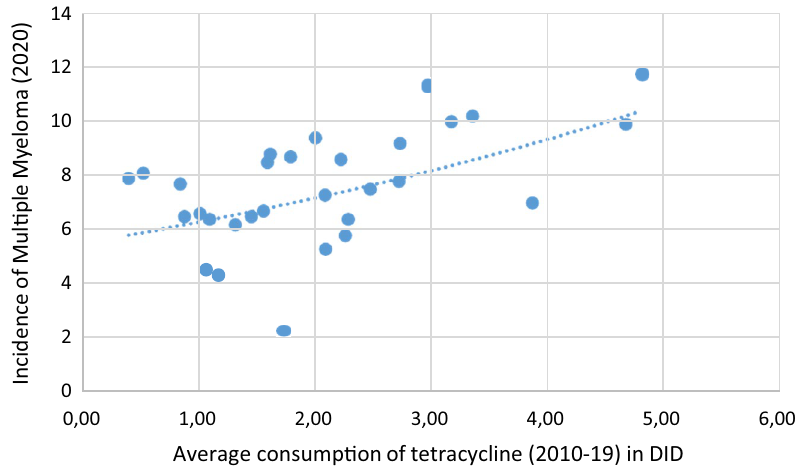
Figure 2. A significant positive association was seen between tetracycline consumption and the incidence of MM (2020).